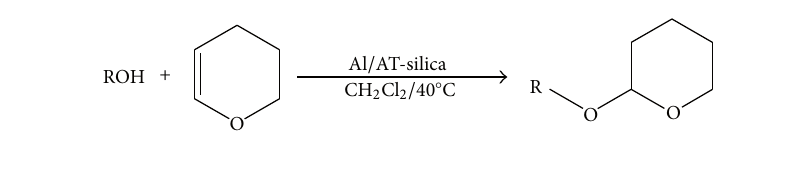
S 1: Preparation of AT-silica.